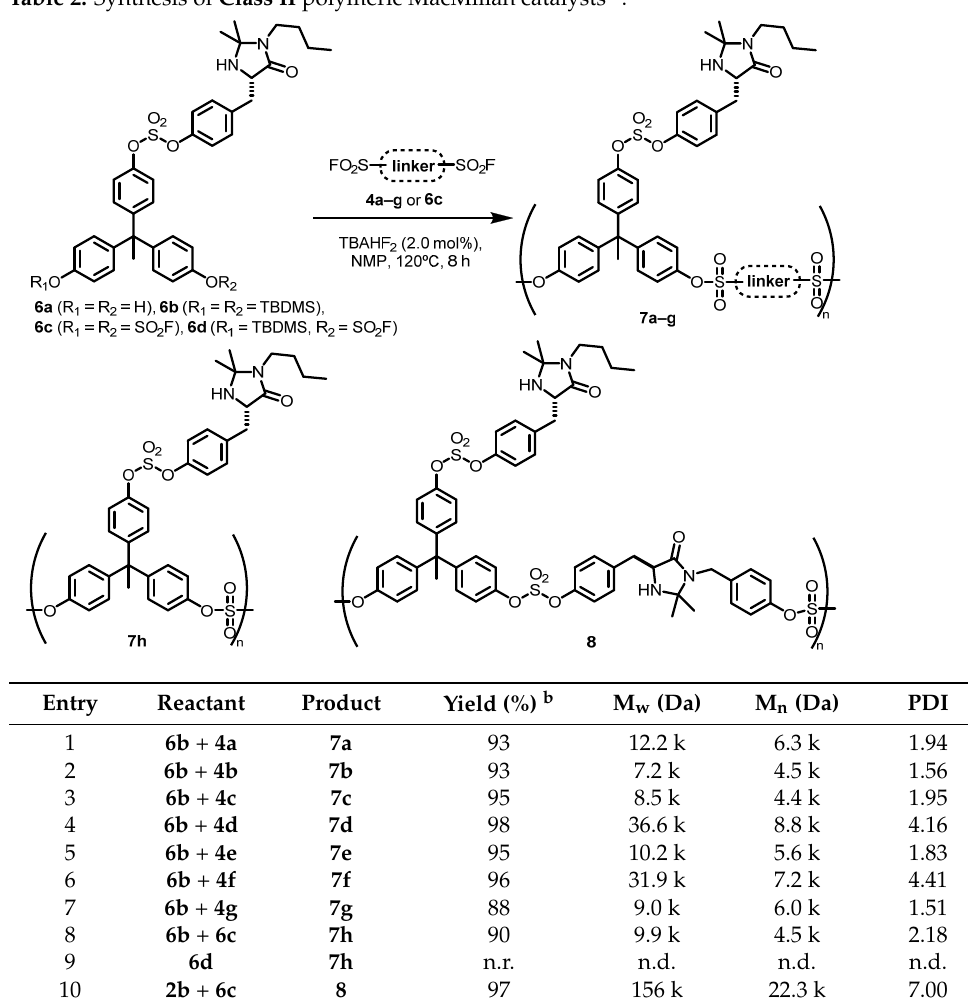
Table 2. Synthesis of Class II polymeric MacMillan catalysts a .